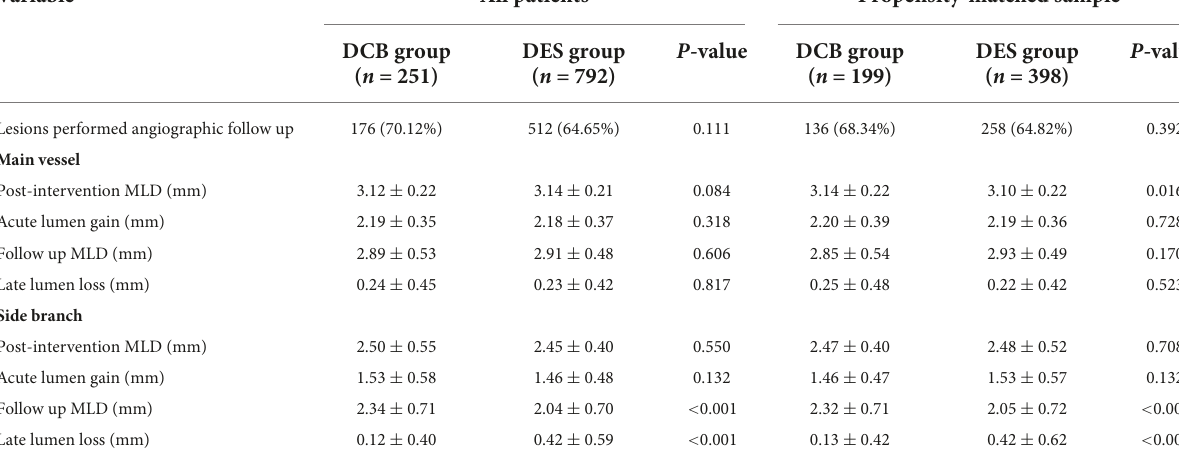
TABLE 5 Quantitative coronary angiographic (QCA) results before and after propensity-score matching*. Variable All patients Propensity-matched